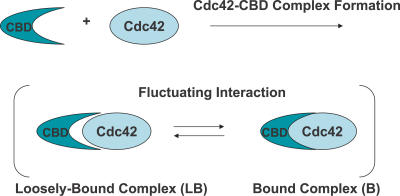
An Illustration of Two State Cdc42-CBD BindingThe loosely bound state was presumably a subset of conformations that deviated from the bound equilibrium states, probed by the dye, without disrupting the subnanometer long-range interactions, so the overall protein complex was still associated.